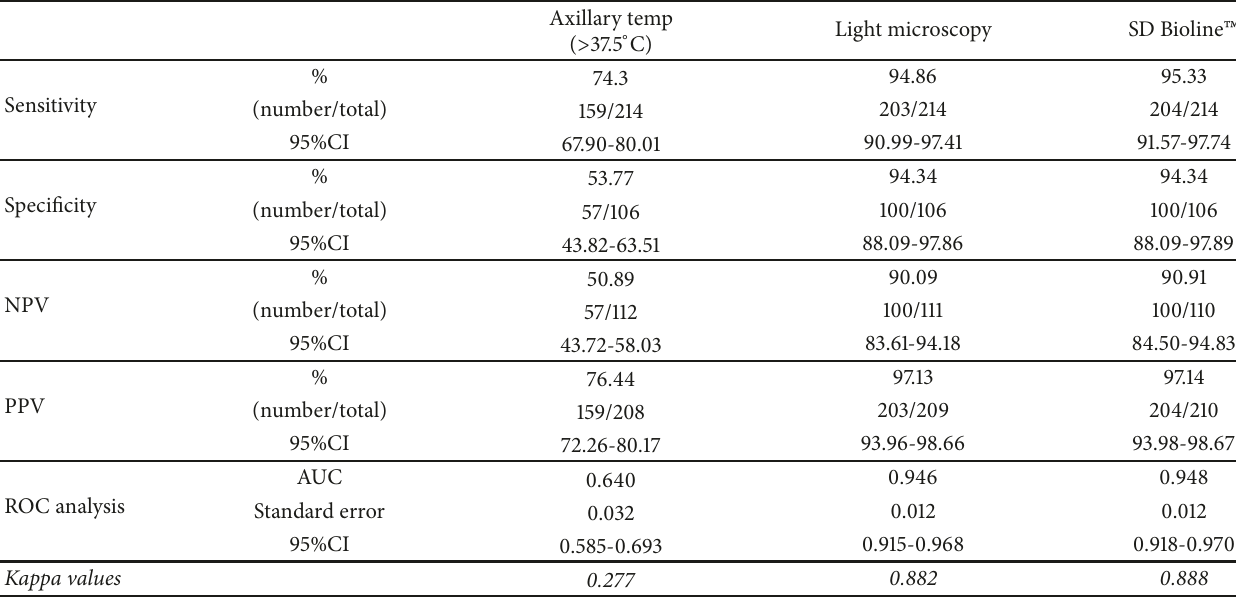
Table 3: Diagnostic sensitivity, specificity, PPV, NPV, and ROC analysis, and kappa values of agreement between test